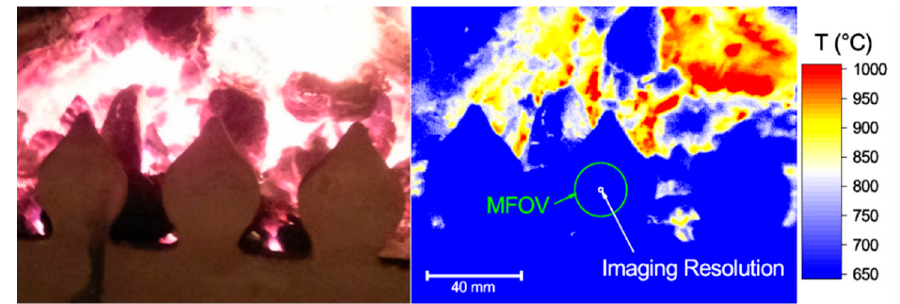
Figure 5. A representative thermal image of a lit domestic wood and coal burning stove. The imaging resolution is sufficient to resolve details of the scene. The MFOV determines the minimum uniform feature size for which a truly quantitative measure of the temperature can be made.